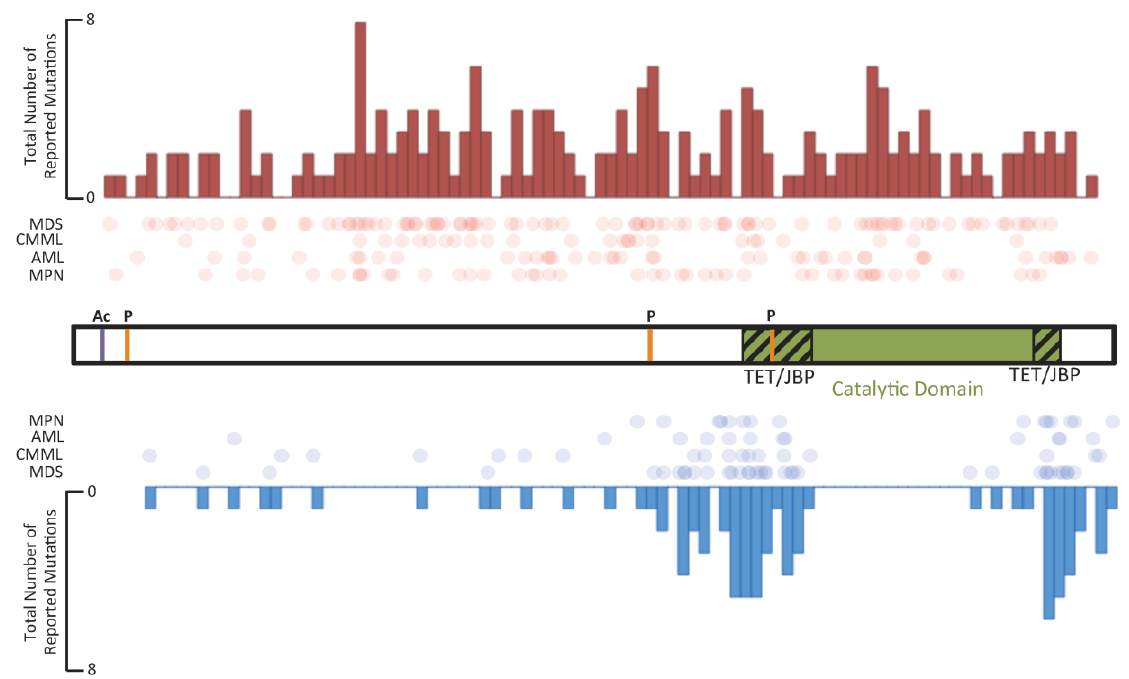
Figure 5. The overall frequency of nonsense and frameshift mutations and missense mutations in TET2. The TET2 protein is shown schematically in the center of the figure. Phosphorylation and acetylation sites are marked on the protein schematic in orange and purple, respectively. The catalytic domain, which is composed of two TET/JBP domains separated by a spacer region, is highlighted in green near the C-terminus. The primary protein structure was divided into seventy-five bins, and the total number of mutations reported for each bin [84,93,95,101,114] is indicated in the histograms. At the top of the figure, nonsense and frameshift mutations are shown as red circles; and at the bottom of the figure, missense mutations are shown as blue